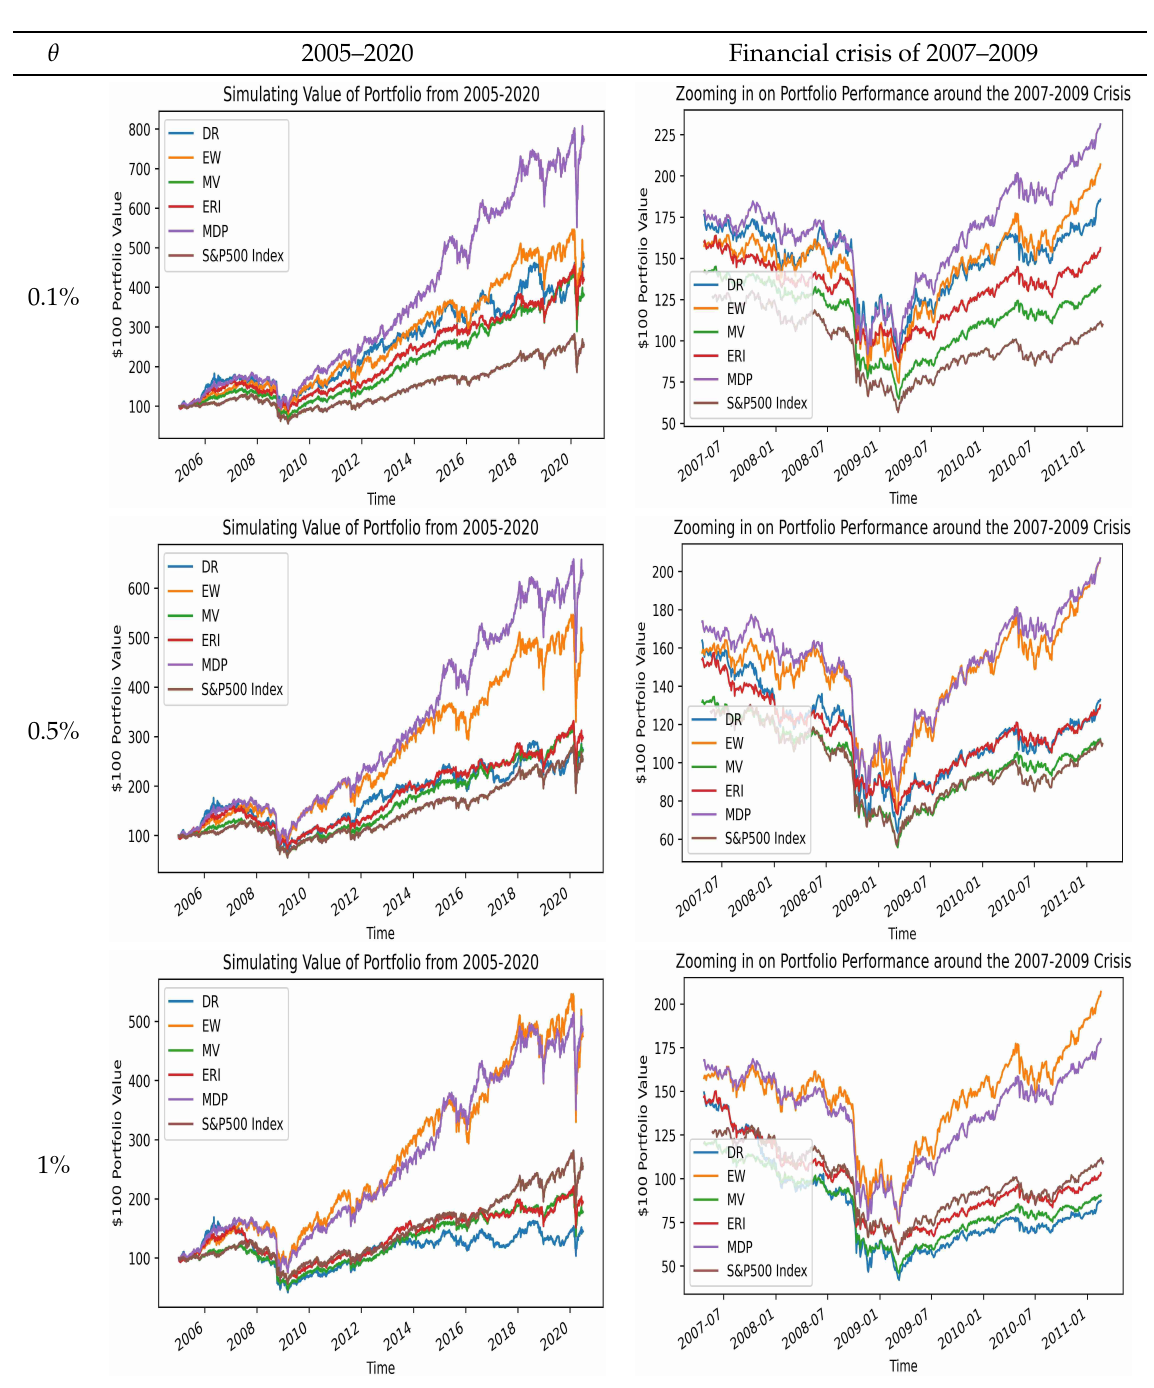
Figure A6. Portfolio values with transaction cost for grouped stocks with tail indices α > 3.5 when θ = 0.1%,0.5%,1%, θ fc = 1.5 θ